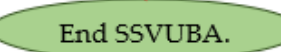
Figure 1. Flowchart of SSVUBA.